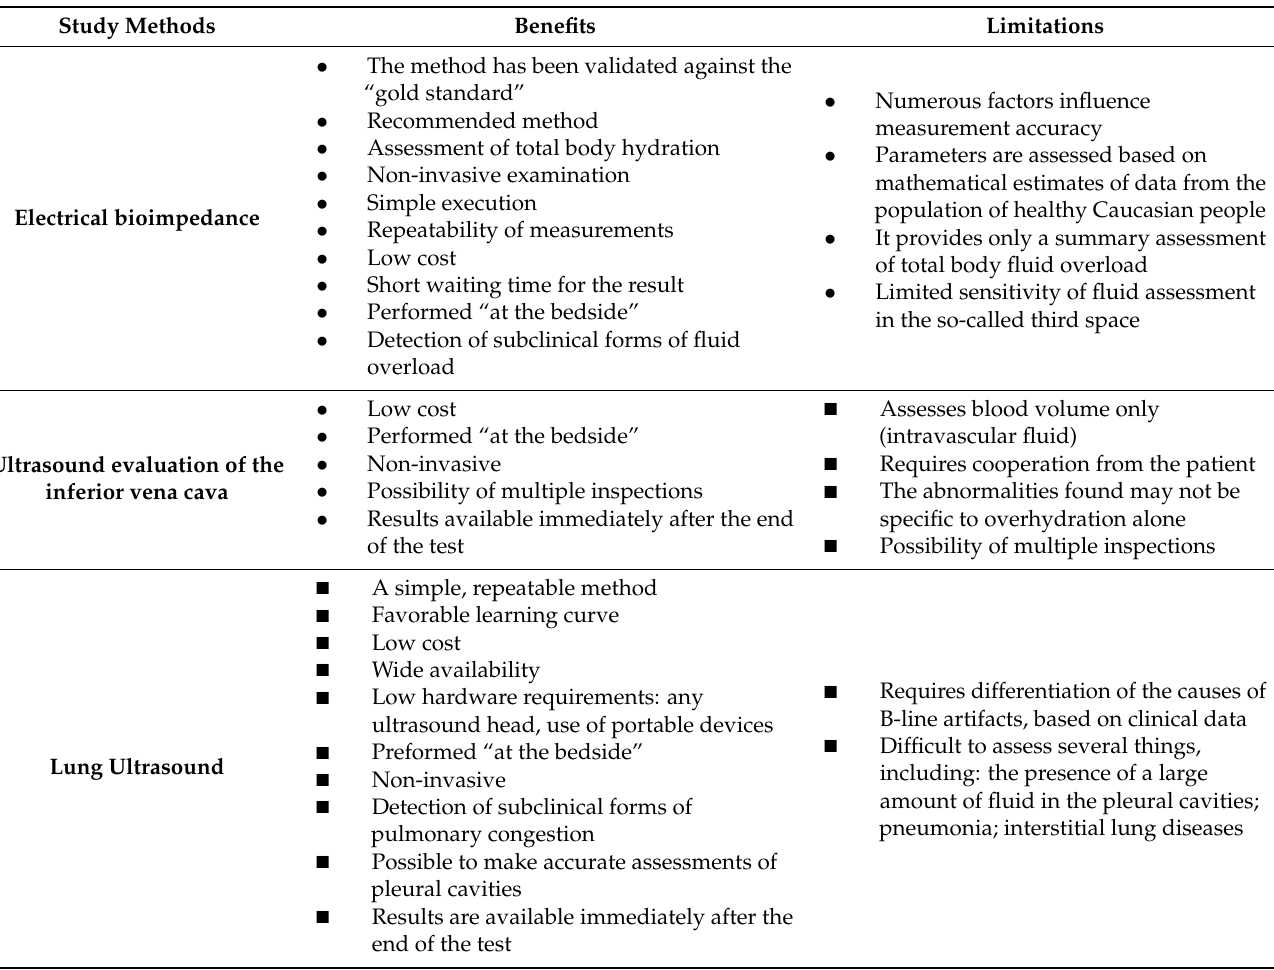
Table 1. Benefits and limitations of additional study methods for evaluating